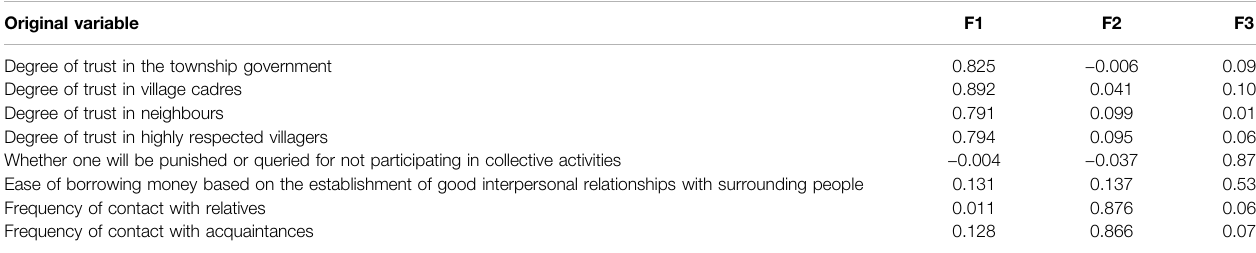
TABLE 2 | Factor loading matrix after